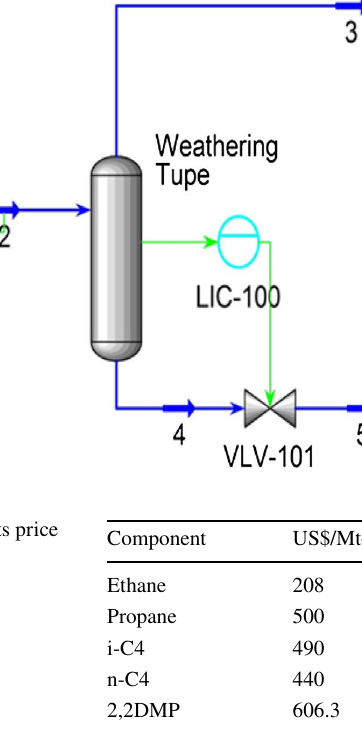
Fig. 3 Dynamic model for weathering of LPG